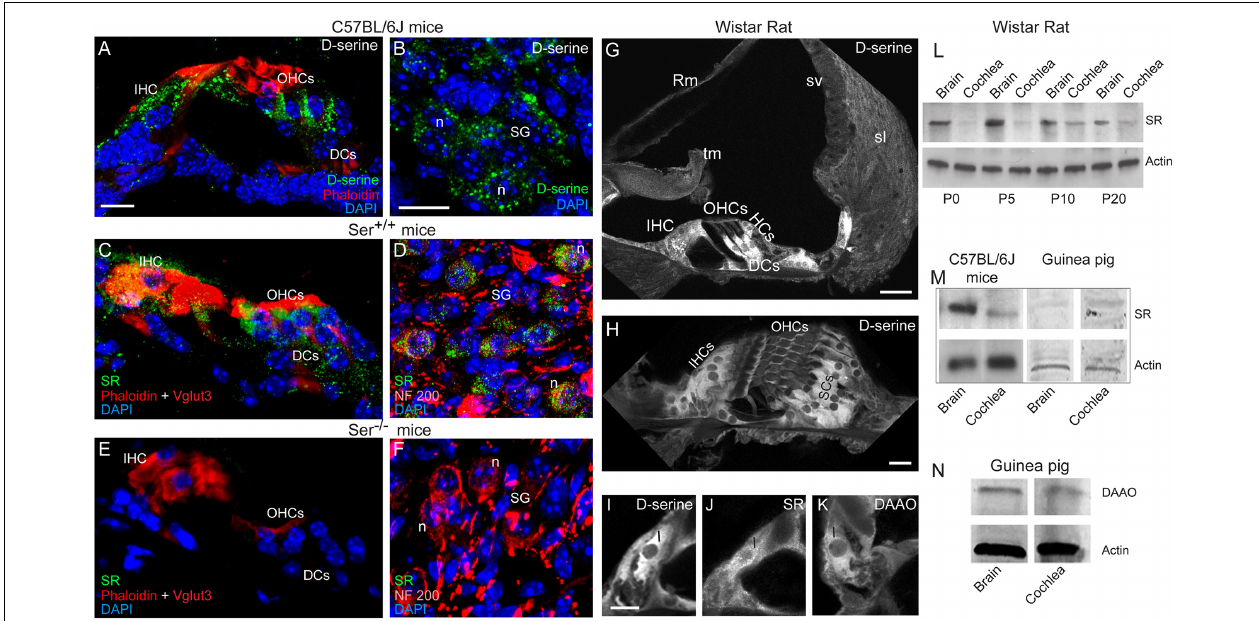
FIGURE 1 | Expression and localization of D-serine, SR and DAAO in mouse, rat and guinea-pig cochleae. (A–F) Confocal images showing the cryostat transversal sections of the basal region of the cochleae from C57BL/6J (A,B) , Ser + / + (C,D) and Ser − / − (E,F) mice. The sections were immunolabeled for D -serine (green in A,B ) or serine racemase (SR, green in C–F ), Vglut3 (red in C,E ) and NF 200 (red in D,F ) to identify the inner hair cells and spiral ganglion neurons, respectively, rhodamine-phalloidin to identify actin (red in A,C,E ) and counterstained with DAPI to stain the nuclei (blue). (G–K) Confocal images showing the vibratome transversal sections of the basal region of adult rat organ of Corti immunolabeled for D -serine (G–I) , SR (J) and DAAO (K) . Scale bars: (A,H,I) = 10 µ m, (BG) = 20 µ m. (L–N) Representative western blot analysis using antibodies against SR, DAAO, and β -actin in whole cochlear extracts from P0 to P20 rat cochlea and brain (L) , adult mouse, and guinea-pig cochlea and brain (M,N) . IHCs, inner hair cells; OHCs, outer hair cells; DCs, Deiters cells; Hcs, Hensen’ cells; Rm, Reissner’s membrane; tm, tectorial membrane; sv, stria vascularis; sl, spiral ligament; I, inner hair cell; SCs, supporting cells; sg, spiral ganglion; n,